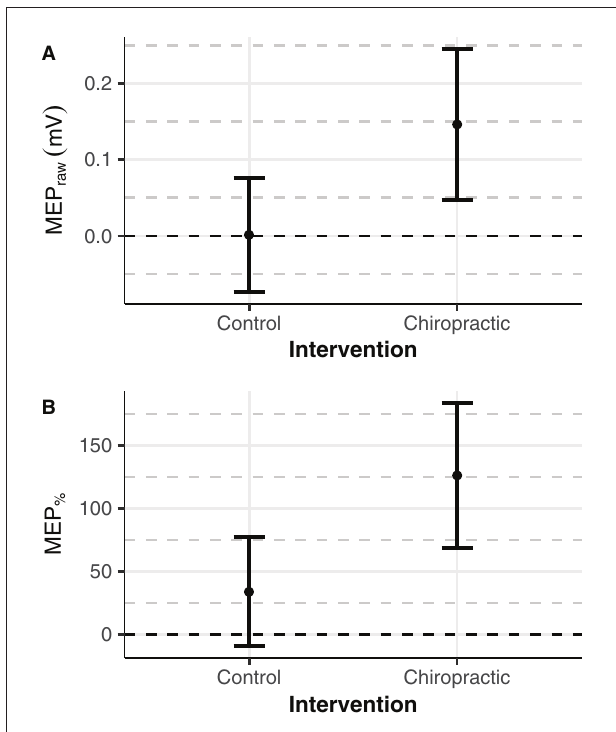
FIGURE 2 | Estimated means of MEPs. Error bars represent mean ± 95 CI. The marginal means were estimated with pre-intervention values set to 0 (black dashed line). (A) Compared to post-control intervention, increased MEPs size was found after the chiropractic spinal manipulation by (A) 0.15mV in absolute units and (B) 92% in relative